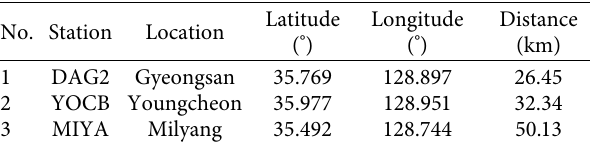
Table 3: Information on the three earthquake monitoring